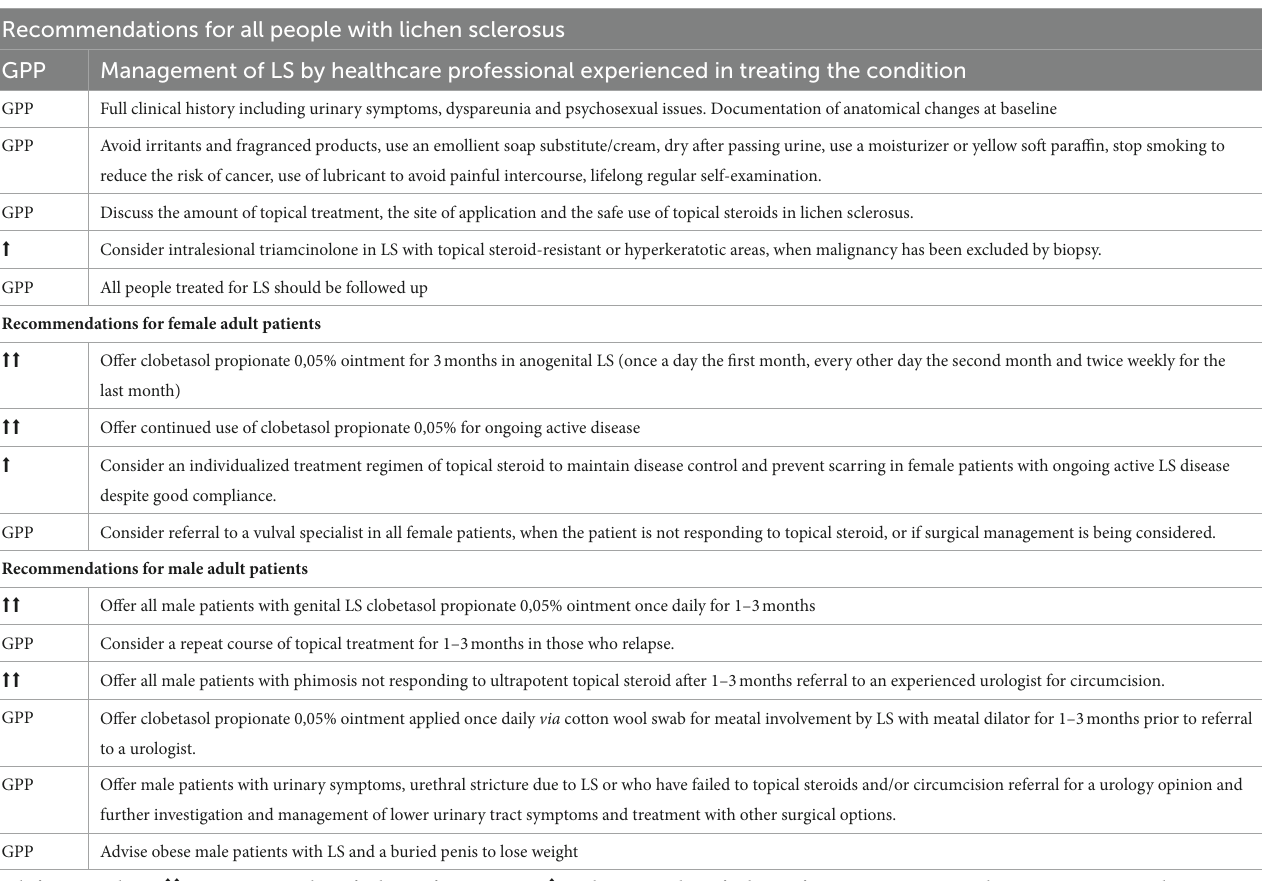
TABLE 6 Summary of recommendations for adults with lichen sclerosus (LS; Modified from the British Association of Dermatologists guidelines, 2018) (124). Recommendations for all people with lichen